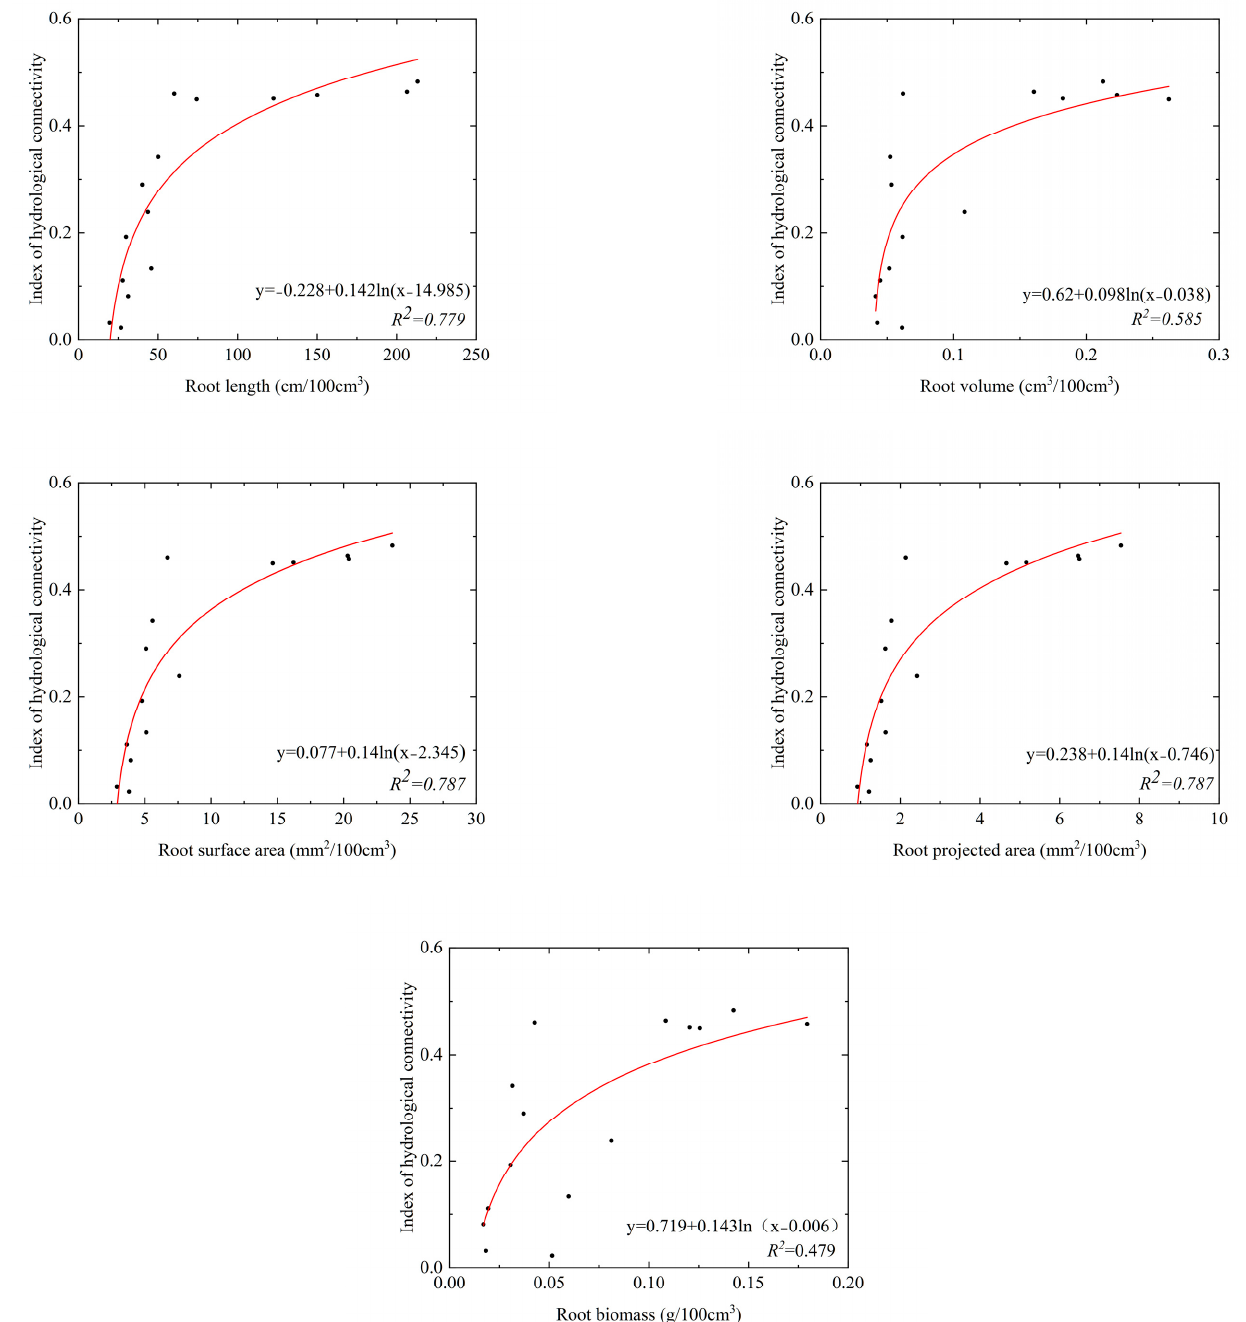
Figure 5. The relationship between the parameters of roots system architecture and IHC in the SS site.